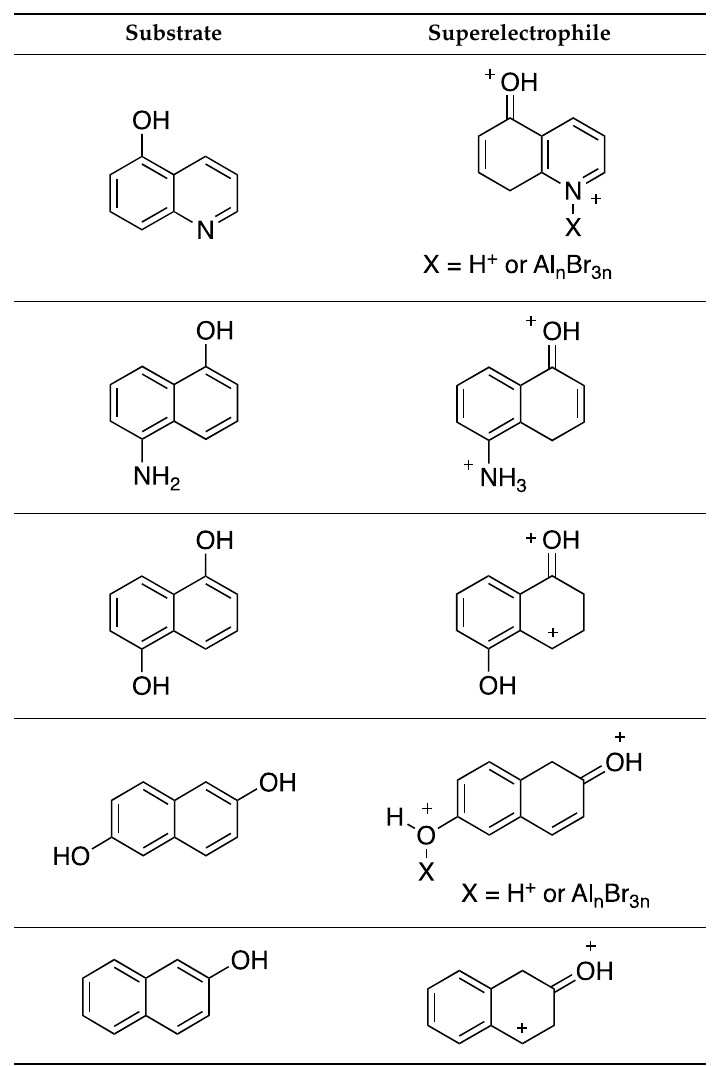
Table 1. Naphthols and related compounds with the resulting superelectrophiles.